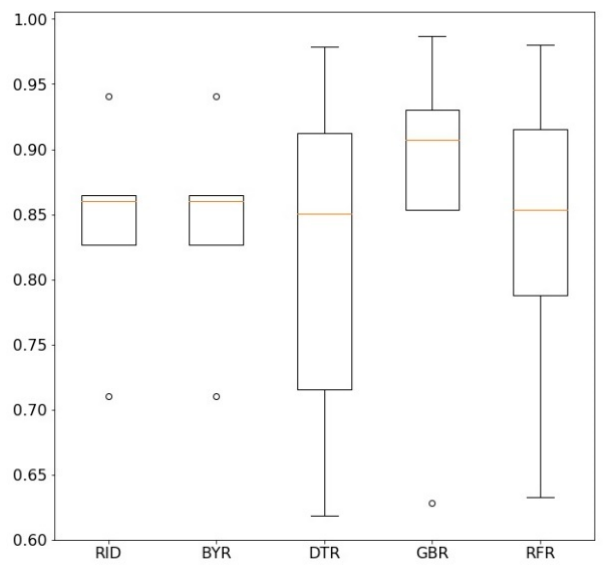
Figure 7. Algorithm comparison.